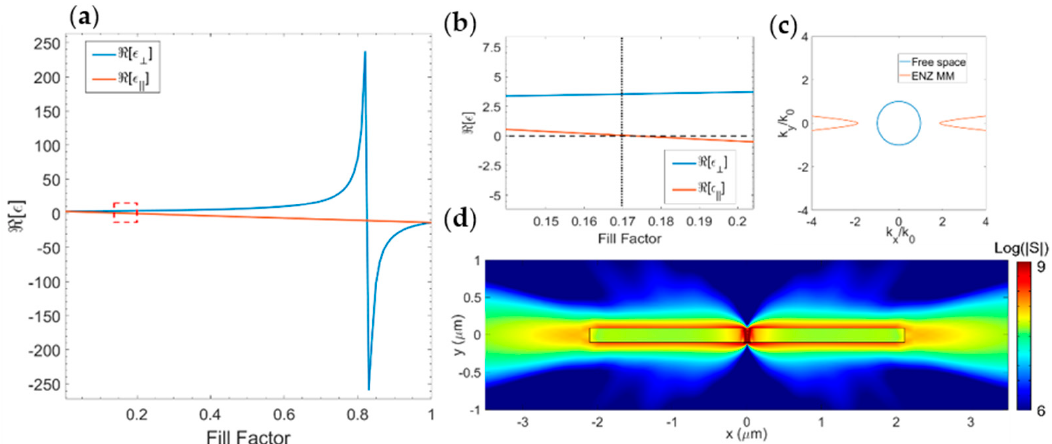
Figure 2. ( a ) Real part of the permittivity components as a function of the metal fill factor in the effective medium approximation. ( b ) Magnification of the red − dotted region highlighted in Figure 1a, showing the region in which the horizontal emission is expected. ( c ) Isofrequency curves for the air (blue circle) and the ENZ metamaterial (red line) resulting from Equation (3) when ε ⊥ = 3.508 + 0.058i and ε || = 0.032 − 0.006i. ( d ) The magnitude of the Poynting vector plotted for the effective medium with a fill factor equal to 0.17 at λ = 637 nm.